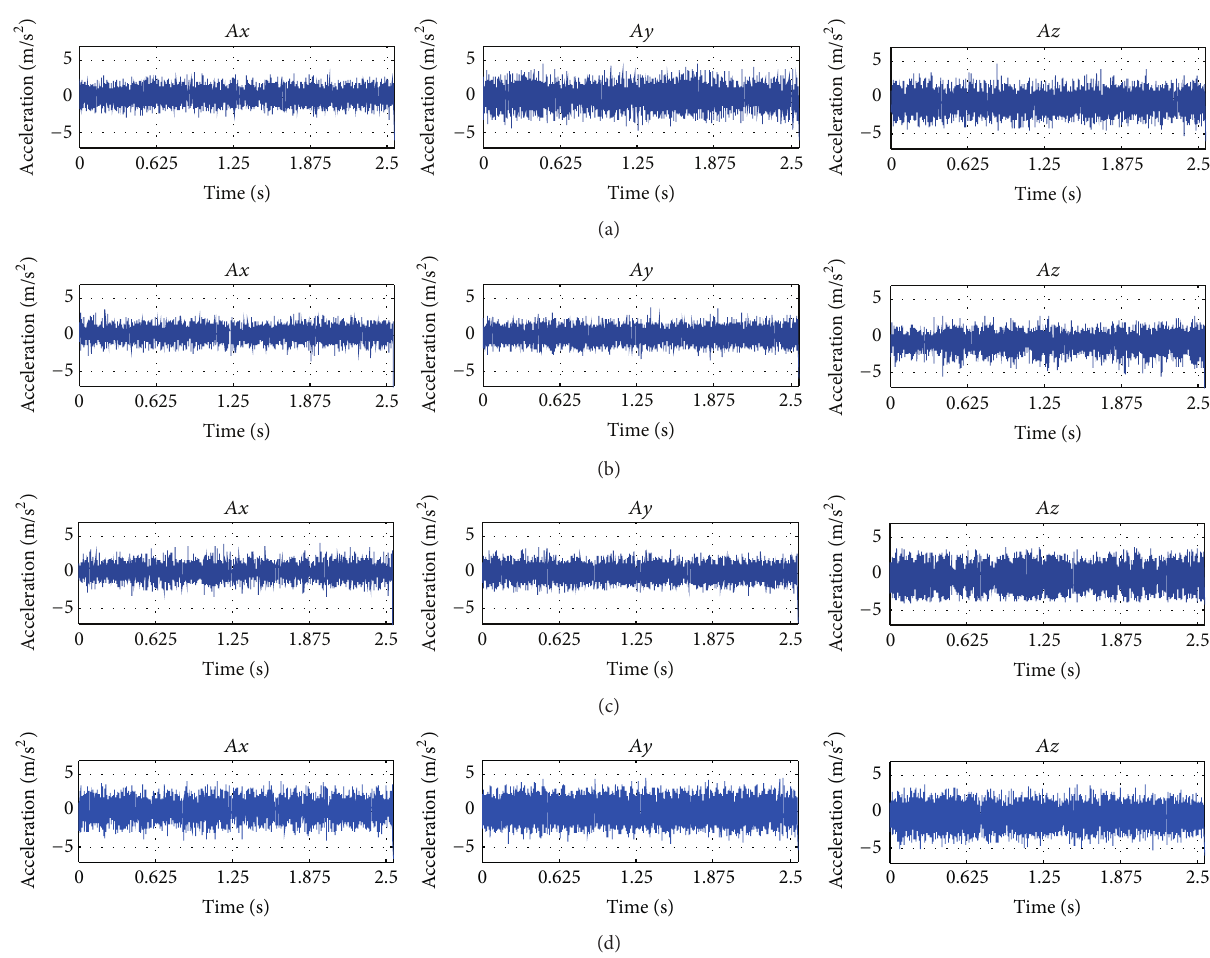
Figure 4: Vibration signals for steady state: (a) HLT, (b) HBRB, (c) 1BRB, and (d) 2BRB.